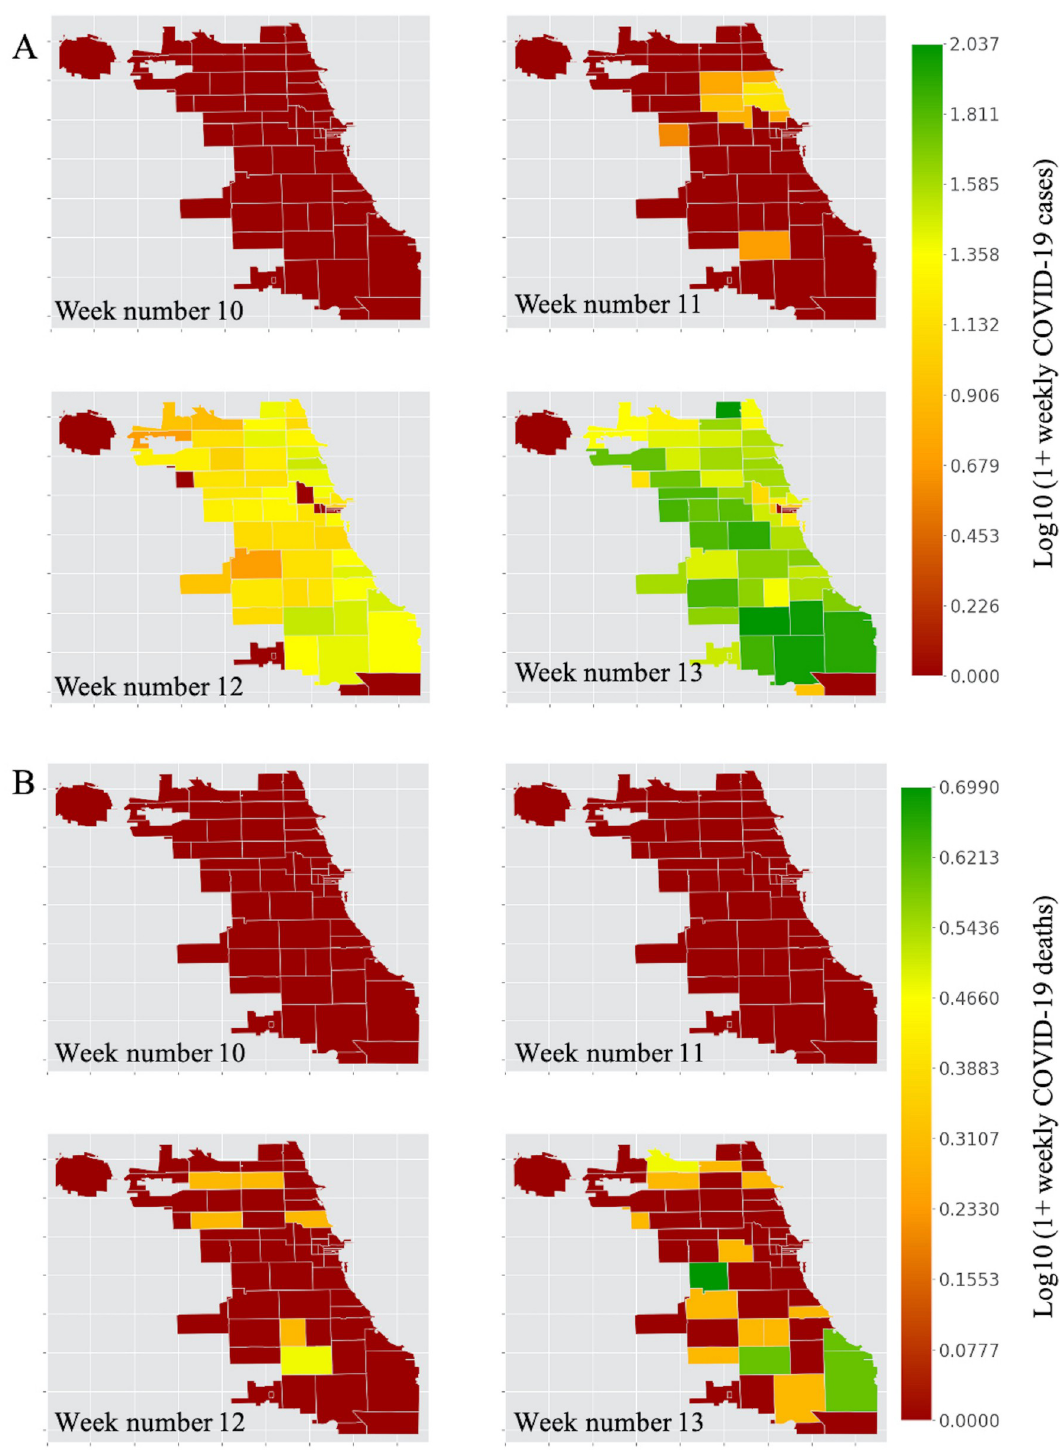
Fig 7. The color of the Chicago zip code is proportional to the weekly COVID-19 cases (log10 transformed). (A) The number of COVID-19 cases spreads almost uniformly across all the taxi zones by the 13 th week of 2020. (B) The deaths related to COVID-19 appear to have greatly affected the southern taxi zones of Chicago as compared to the other zones.